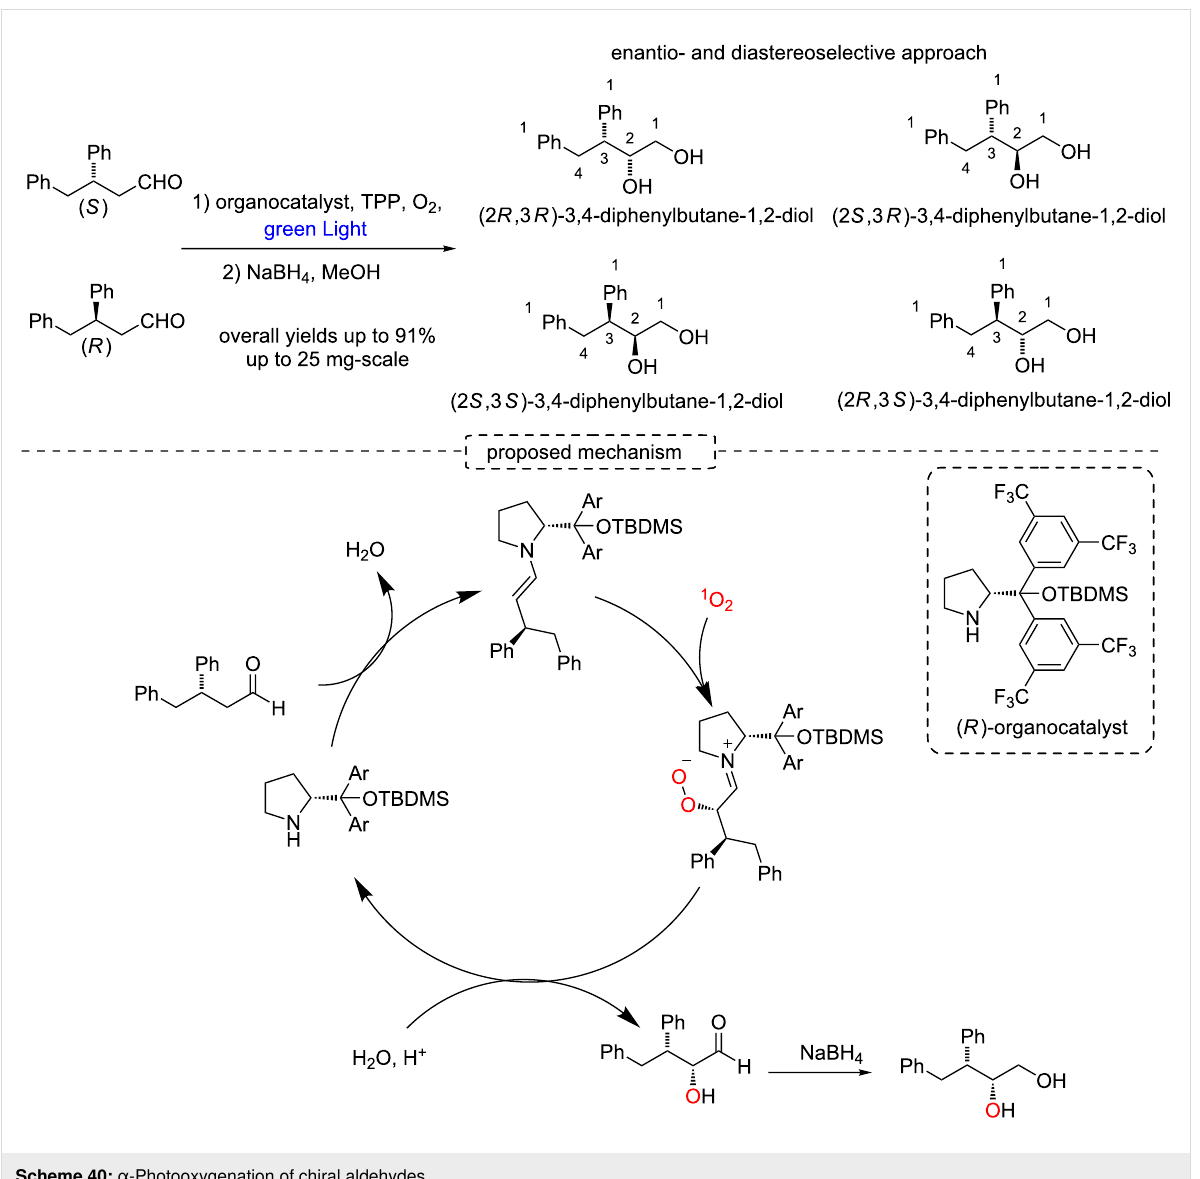
Scheme 40: α -Photooxygenation of chiral